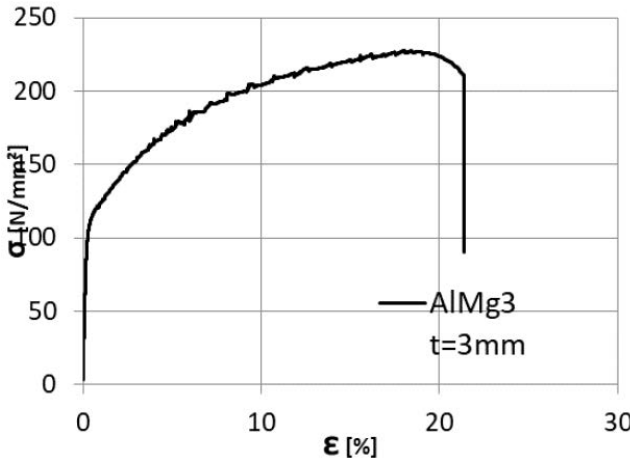
Figure 11. FEM part.